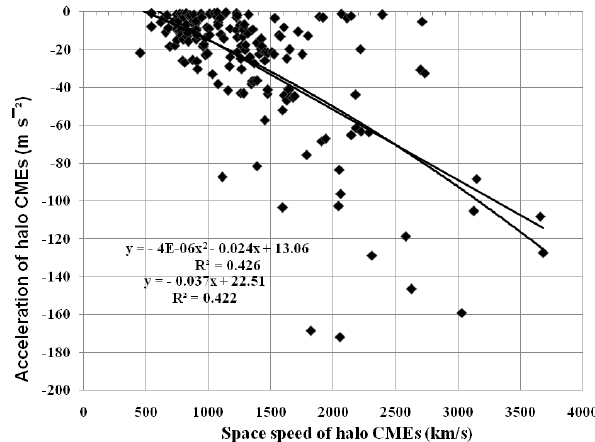
Figure 5. A plot of the space speed of HCMEs (km/s) versus retar- dation of the HCMEs (m/s 2 ). The linear equation and two-degree polynomial are fitted to the space speed of HCMEs and the retarda- tion of